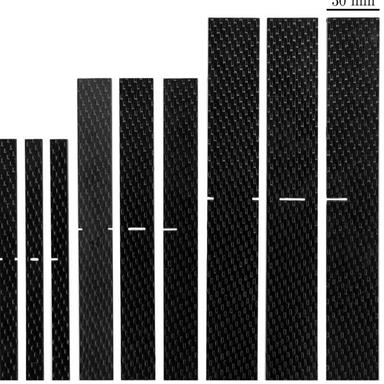
Manufactured notched specimens (DENT, CNT, and SENT) of three scaled sizes.